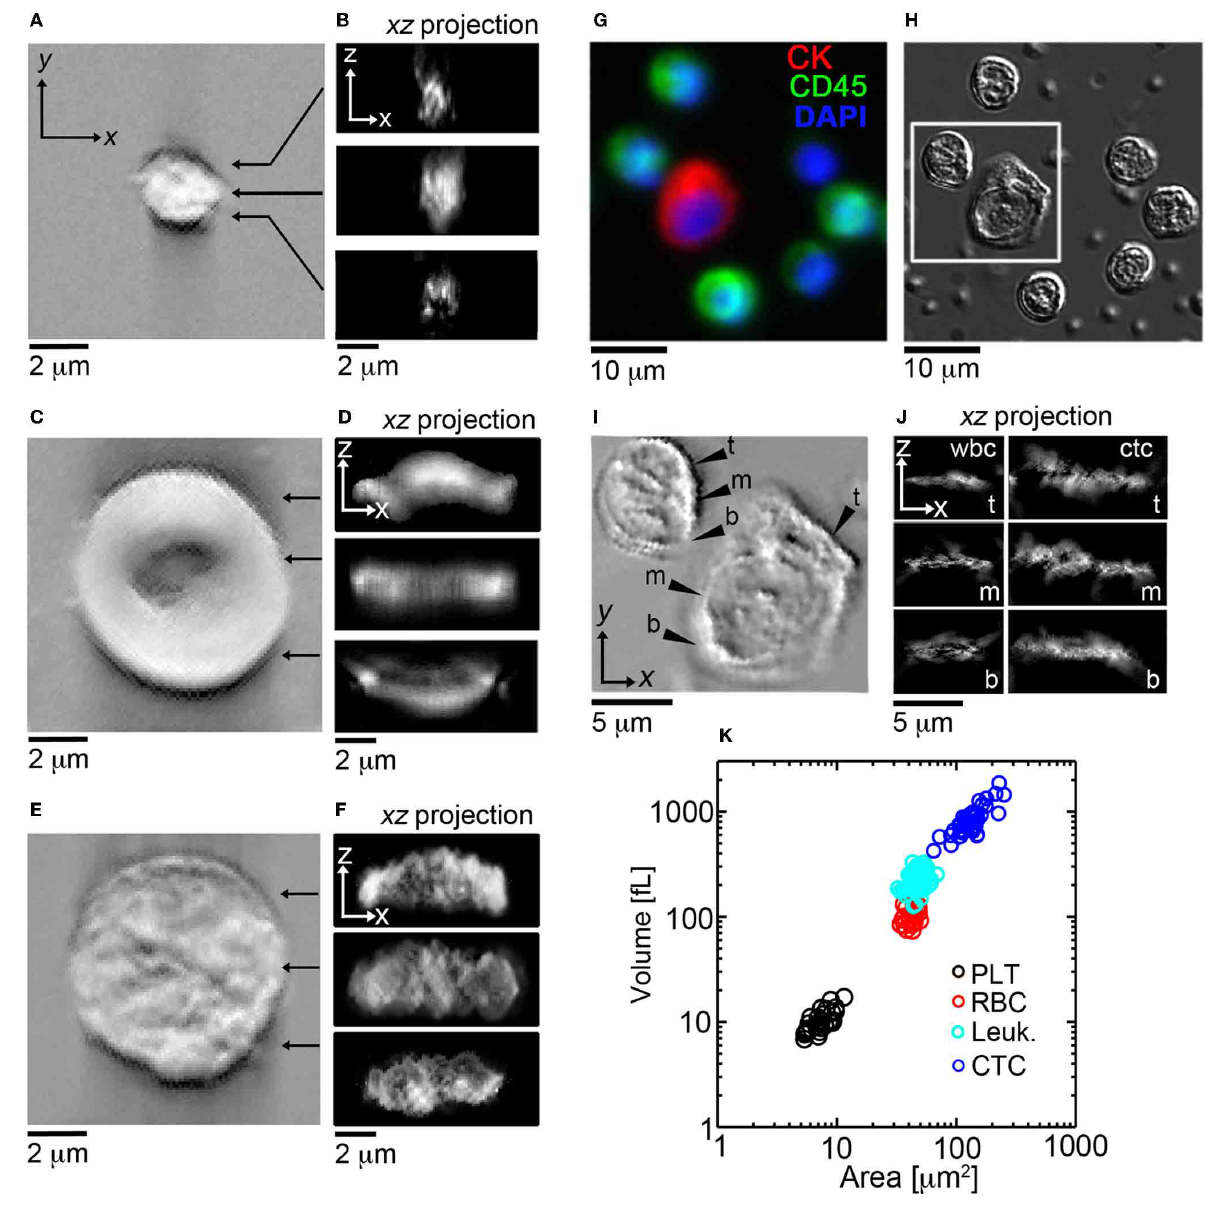
FIGURE 3 | En face and cross sectional post-processed DIC images of normal blood cell populations and HD-CTCs. Representative en face and sagittal Hilbert transformed DIC images of (A,B) PLT, (C,D) RBC, (E,F) leukocytes. (G) Merged fluorescence image of HD-CTCs and leukocytes